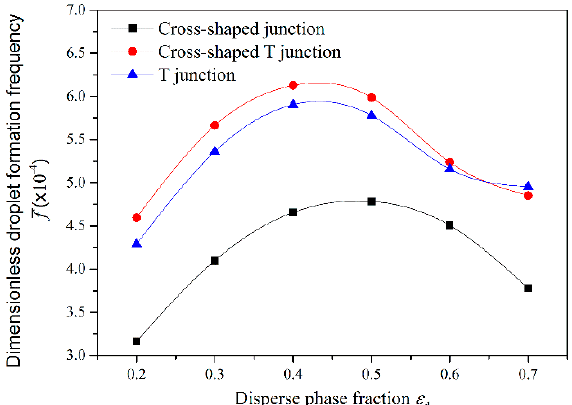
different junction configurations. Processes 2019 , 7 , x FOR PEER REVIEW